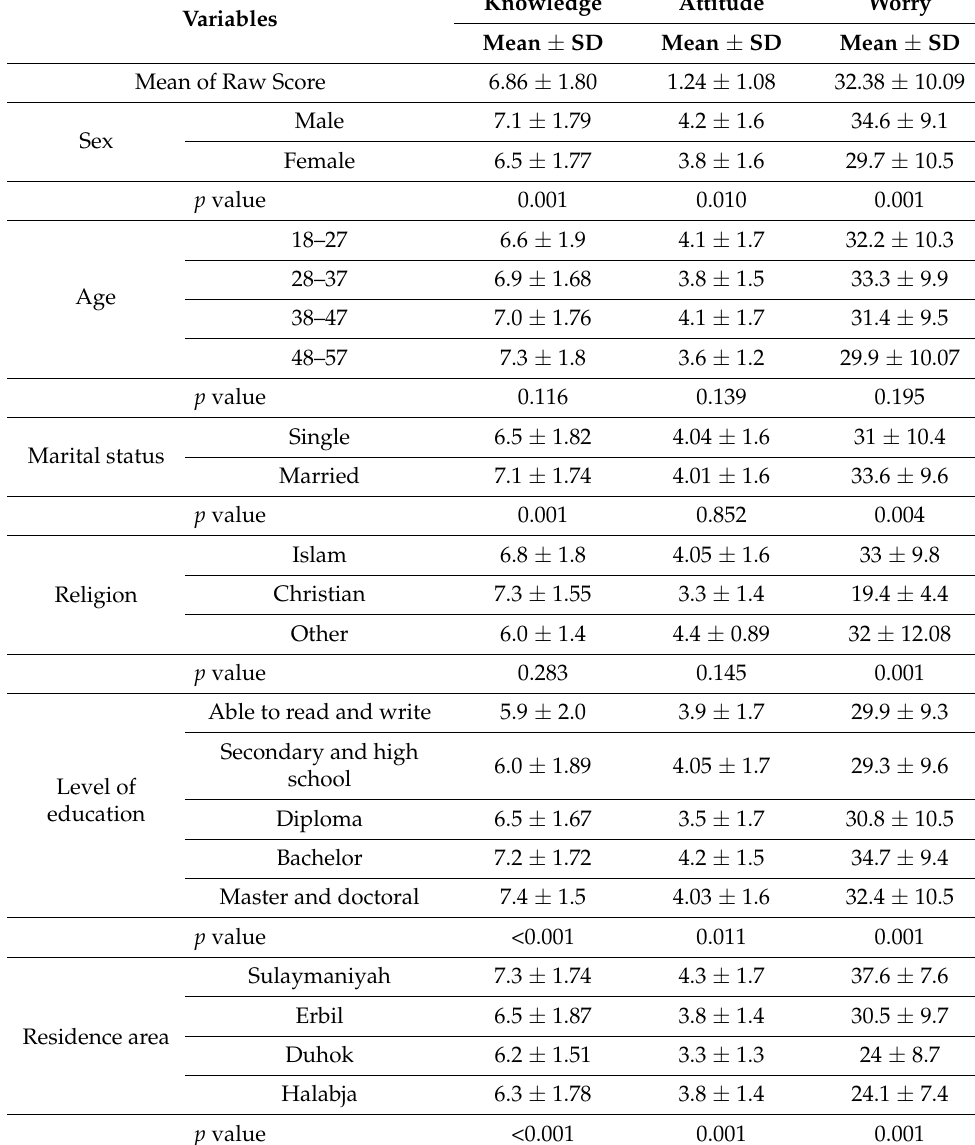
Table 2. Factors associated with score of knowledge, attitude and worry toward mpox ( n = 510). Knowledge Variables